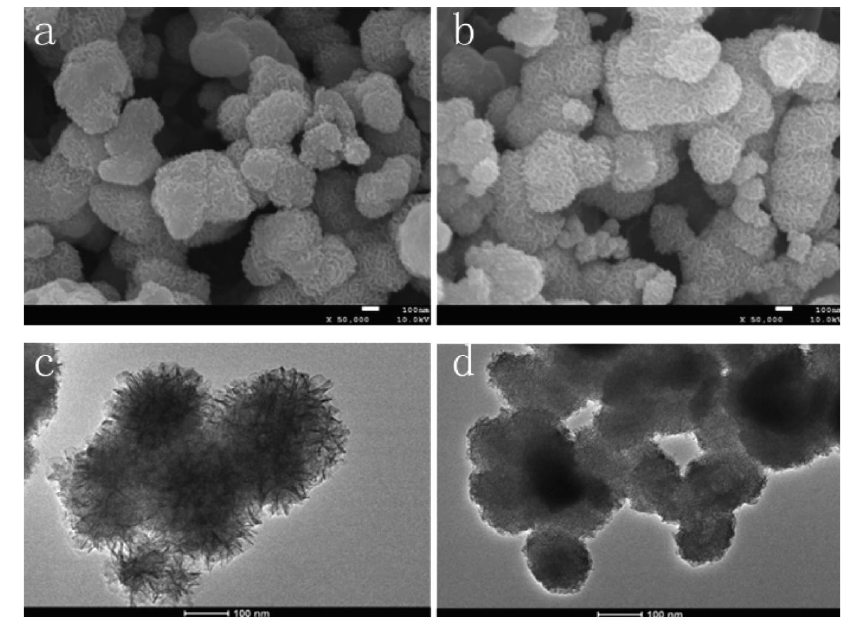
Fig. 2. SEM and TEM images of MnO 2 (a and c) and 0.25 mmol Cu 2+ -doped MnO 2 (b and d)